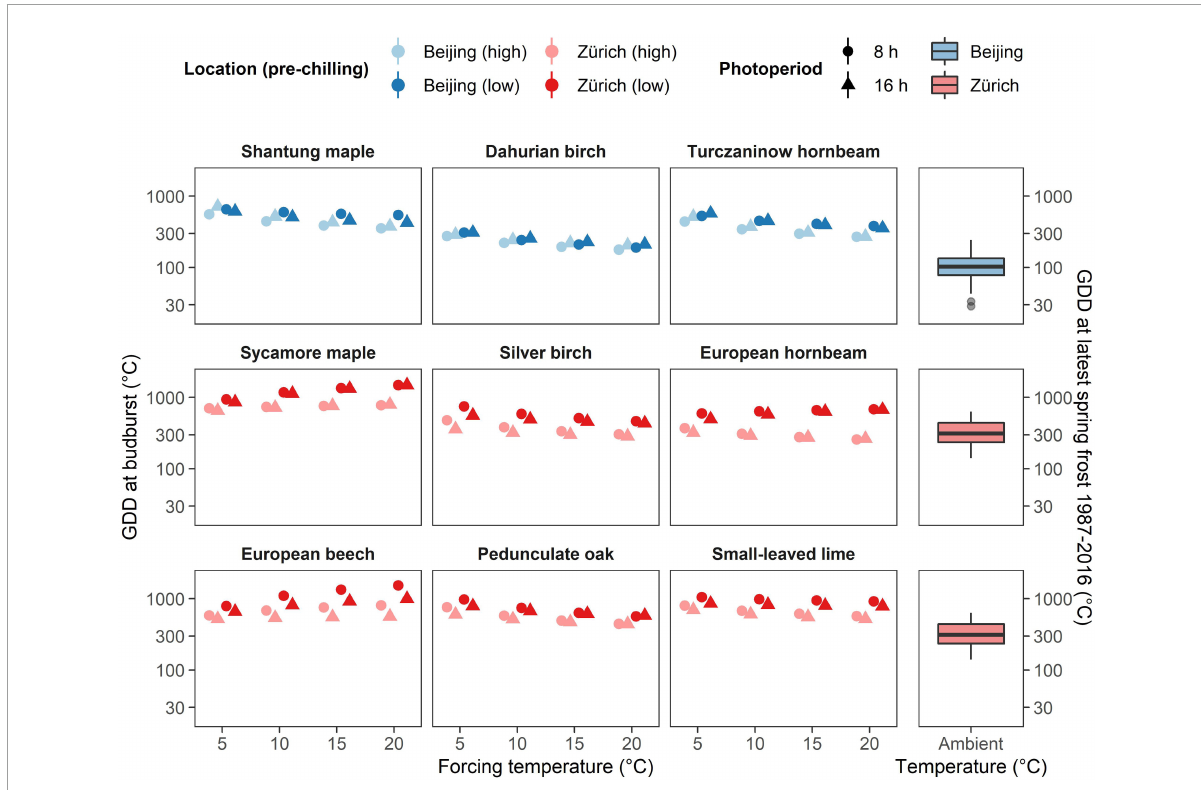
FIGURE4 Required GDD to budburst of the nine species investigated under different forcing temperatures, pre-chilling conditions and photoperiod as predicted by the Bayesian mixed effect model (left) and the observed GDD at latest spring frost at the investigated sites (right). Note the higher distance between predicted GDD requirement and observed GDD near Beijing compared to predicted GDD requirement and observed GDD near Zurich. Note also the weaker influence of pre-chilling conditions (brightness) in East Asian species (upper row) compared to Central European species (lower two